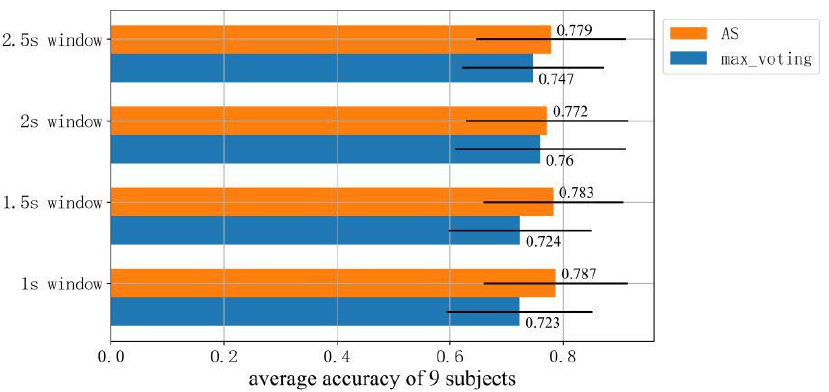
Figure 12. Comparison of classification accuracies of the proposed AS algorithm with the Max Voting algorithm in the case of six windows.